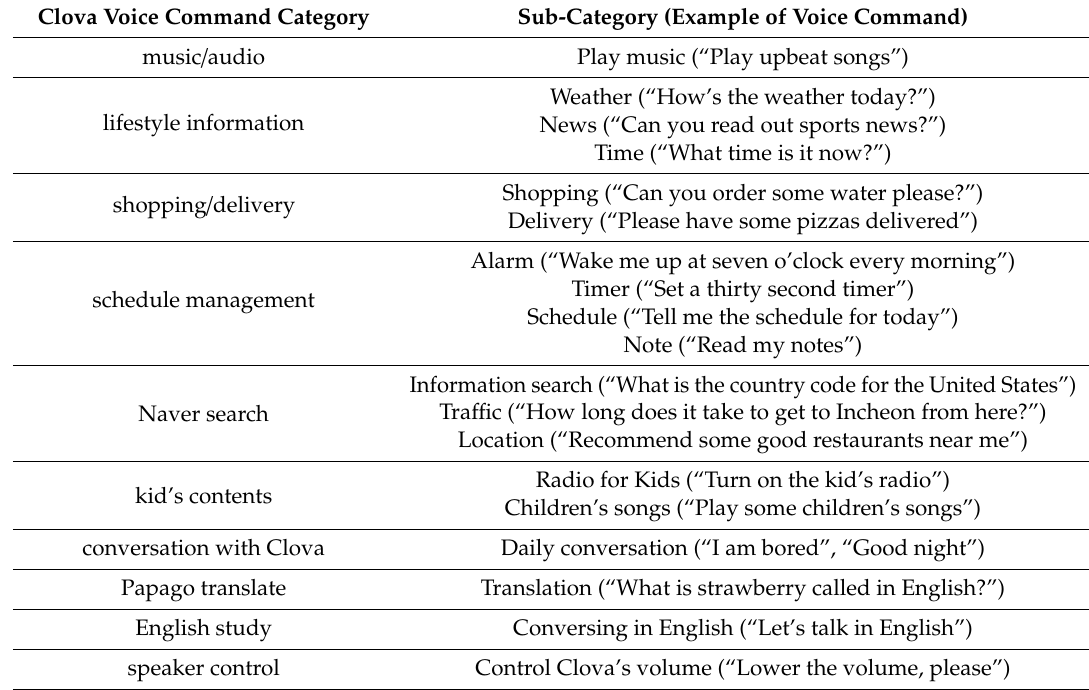
Table 2. Clova’s voice command categories and